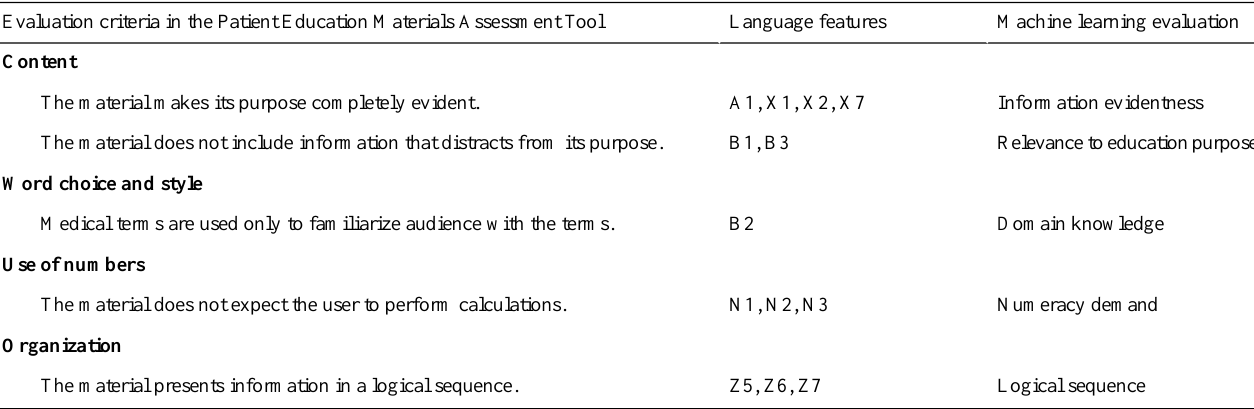
Table 1. Natural language features relevant to Patient Education Materials Assessment Tool